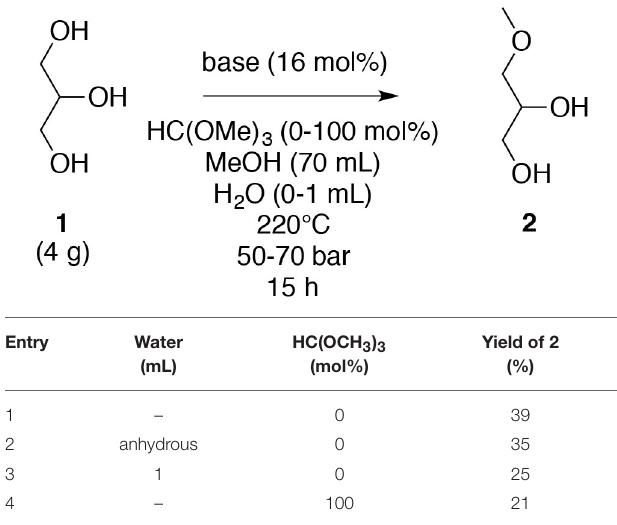
TABLE 4 | Effect of water for the O -methylation of glycerol ( 1 ) in subcritical